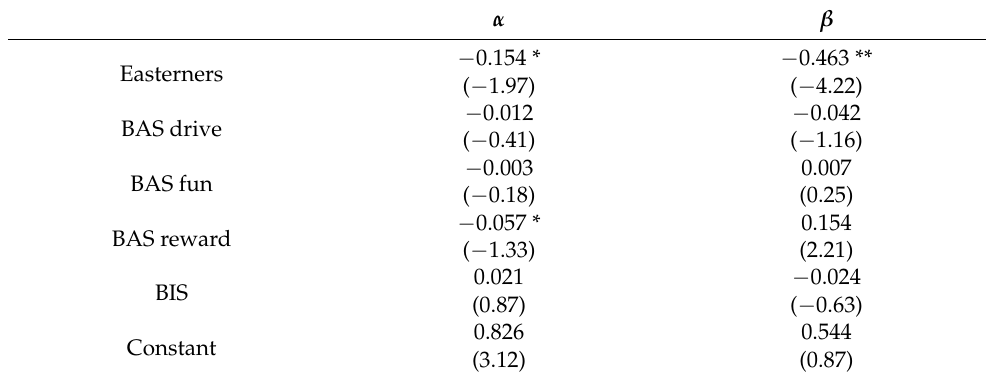
Table 1. Analysis of risk and ambiguity attitudes, including BIS and BAS scores as covariates.